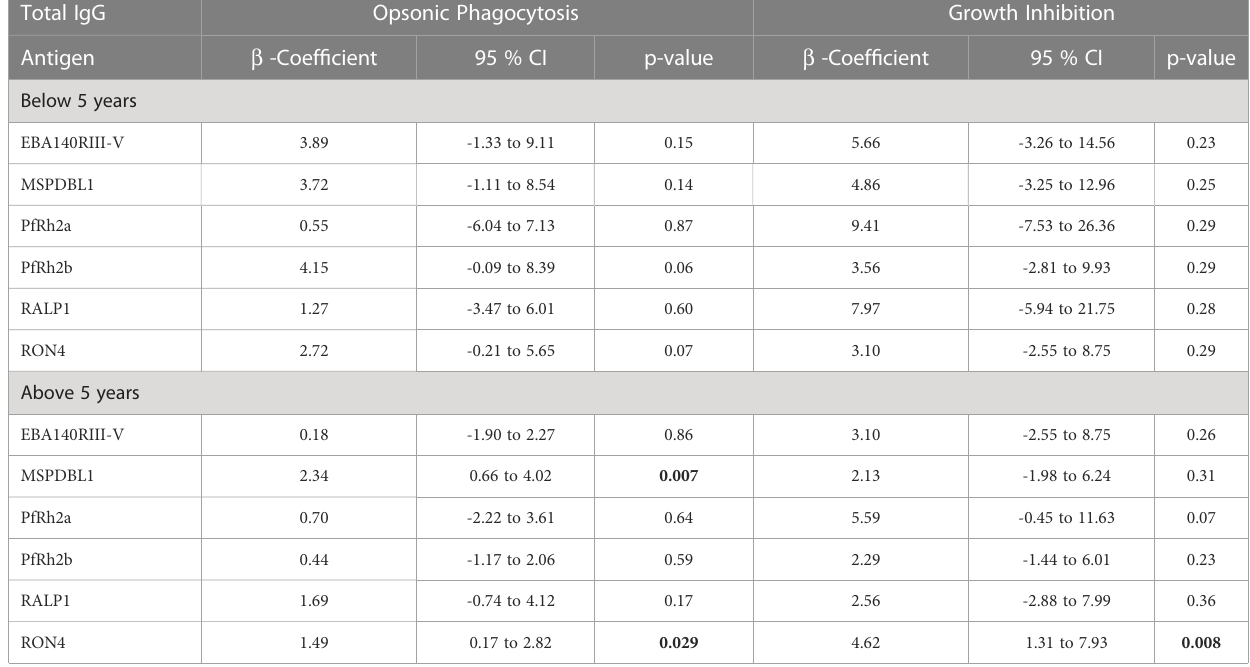
b coef fi cients, 95% con fi dence intervals (95%CI) and p-values for each antigen were obtained with linear regression models for each age group. Signi fi cant p-values are in bold font.